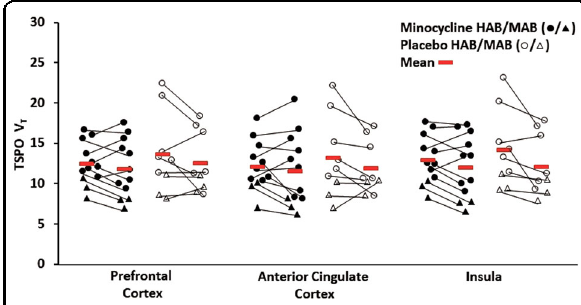
Fig. 2 Effect of oral minocycline treatment on translocator protein total distribution volume in participants with treatment- resistant major depressive disorder. There were no signi fi cant differences in prefrontal cortex, anterior cingulate cortex, or insula TSPO V T between pre- and post-minocycline treatment in the group receiving minocycline as compared to the group receiving placebo (repeated measures ANOVA, effect of group interaction, PFC: F 1,19 = 0.28, P = 0.60; ACC: F 1,19 = 0.54, P = 0.47; insula F 1,19 = 1.6, P = 0.22). All second-generation TSPO radioligands, such as [ 18 F]FEPPA, show differential binding according to the single-nucleotide polymorphism rs6971 of the TSPO gene, resulting in high-af fi nity binders (circles) and mixed-af fi nity binders (triangles). TSPO V T values represent raw values unadjusted for genotype. ANOVA analysis of variance, HAB high- af fi nity binder, MAB mixed-af fi nity binder, TSPO V T translocator protein total distribution volume, [ 18 F]FEPPA, F 18-labeled N -(2-(2- fl uoroethoxy)benzyl)- N